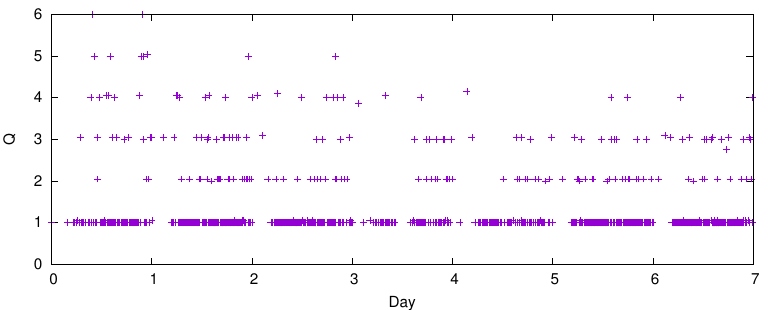
Figure 6. Q-values evolution through learning.